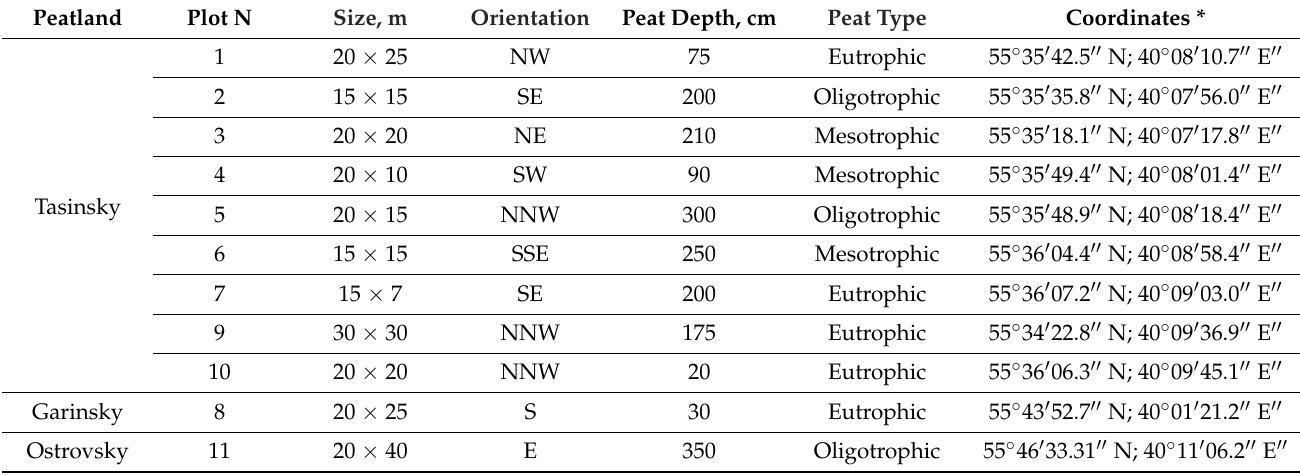
Table 1. Location and characteristics of the monitoring